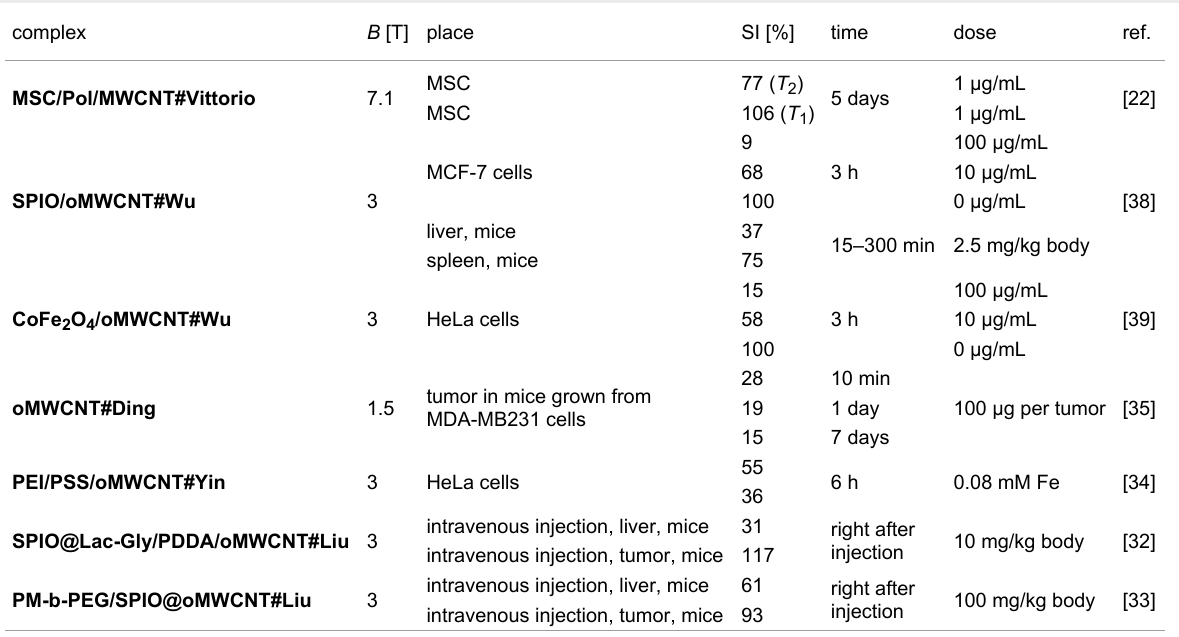
Table 3: In vivo MRI contrast effect of the MWCNT hybrids. a